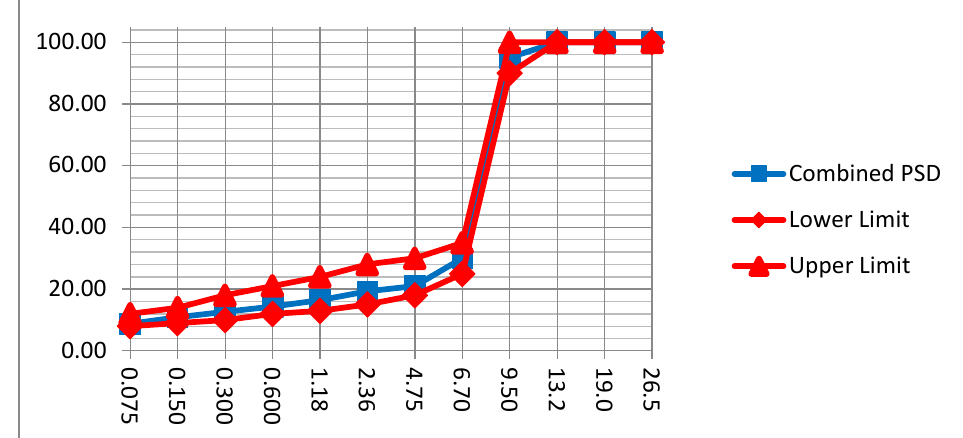
Figure 1. The 0.45 power maximum density curve.